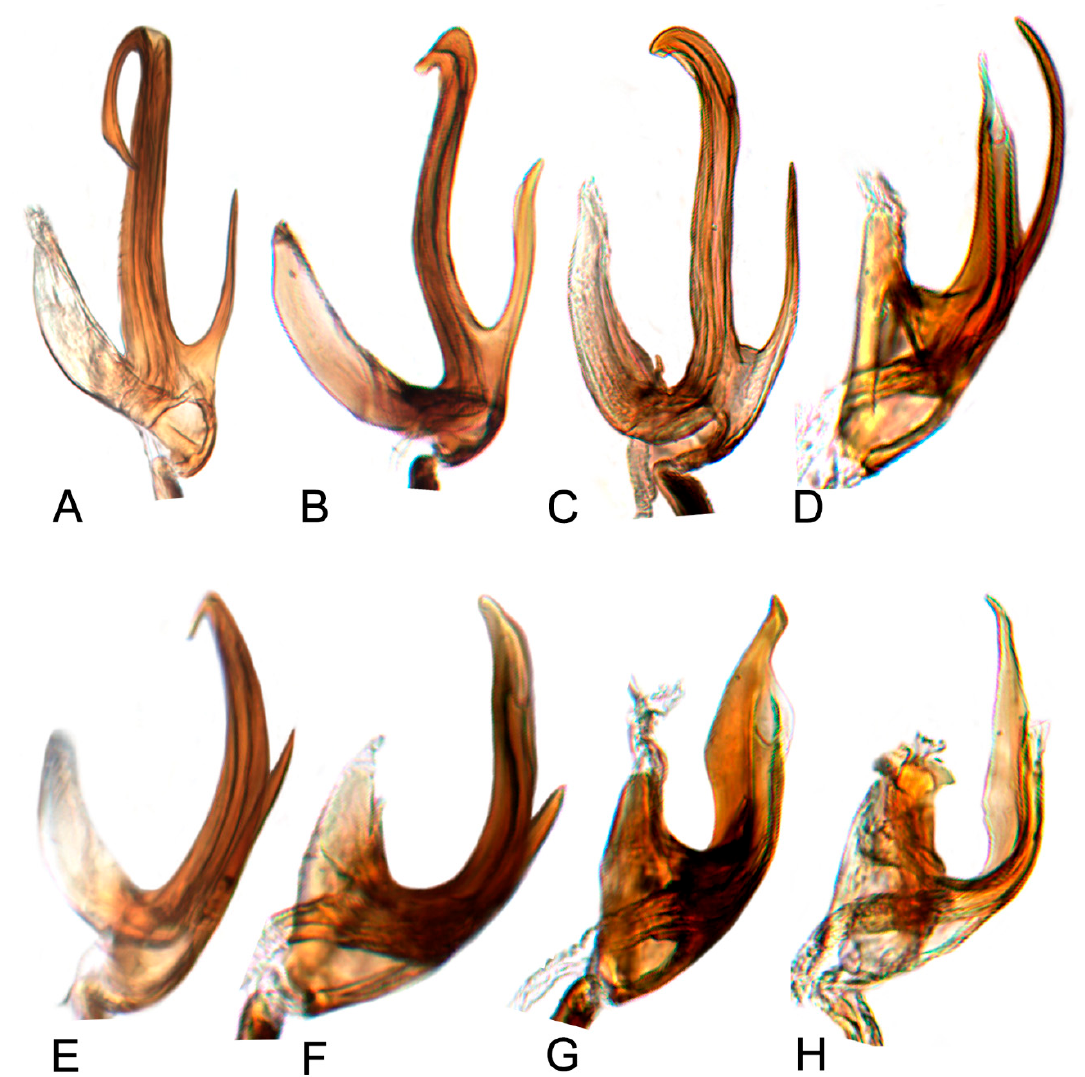
Figure 20. Aedeagus, lateral view. ( A ) H. prolongatus ; ( B ) H. spiniferous ; ( C ) H. kuohi ; ( D ) H. tortuosus ; ( E ) H. aberrans ; ( F ) H. knightiellus ; ( G ) H. tenuis ; and ( H ) H. subtilis .